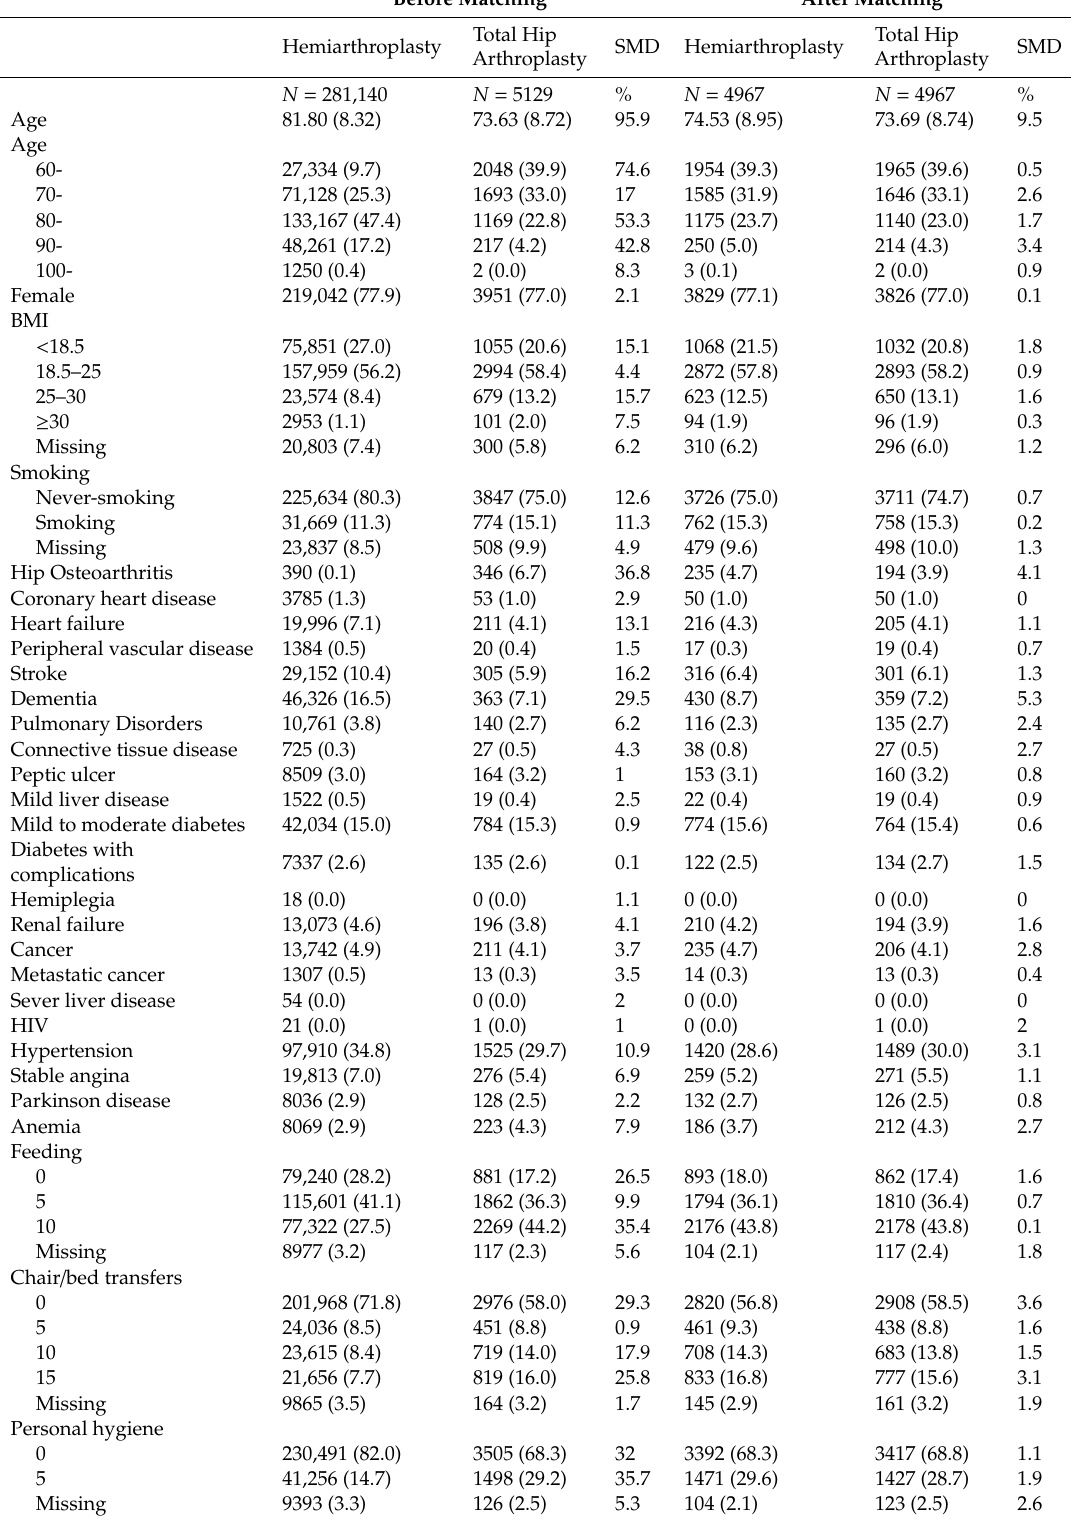
Table A3. Patient characteristics (Full